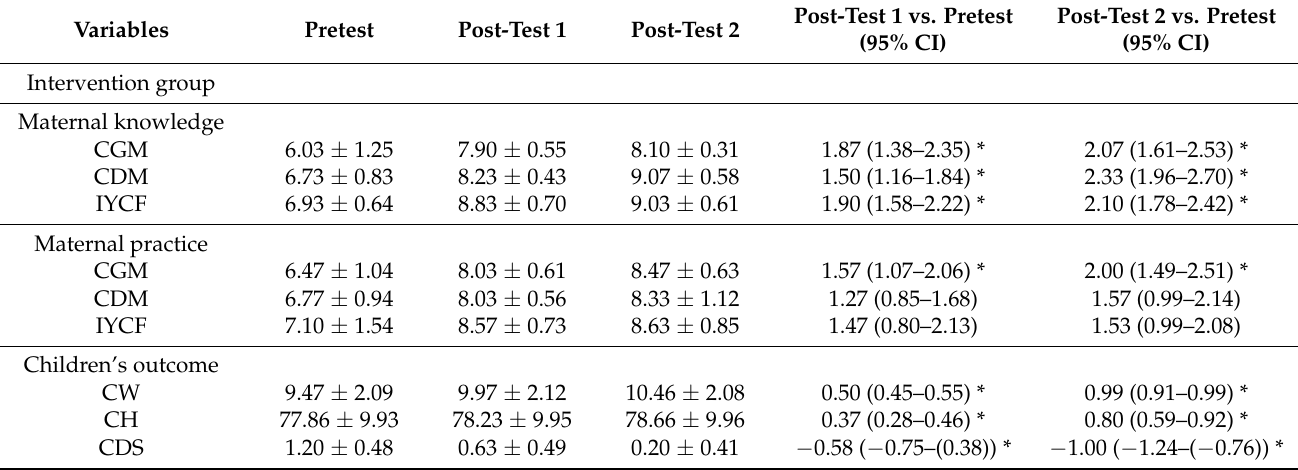
Table 3. Association between time and research outcome among different intervention